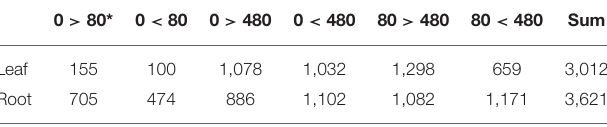
TABLE 2 | Overview of differentially expressed unigenes in leaves and roots of K. sieversiana .